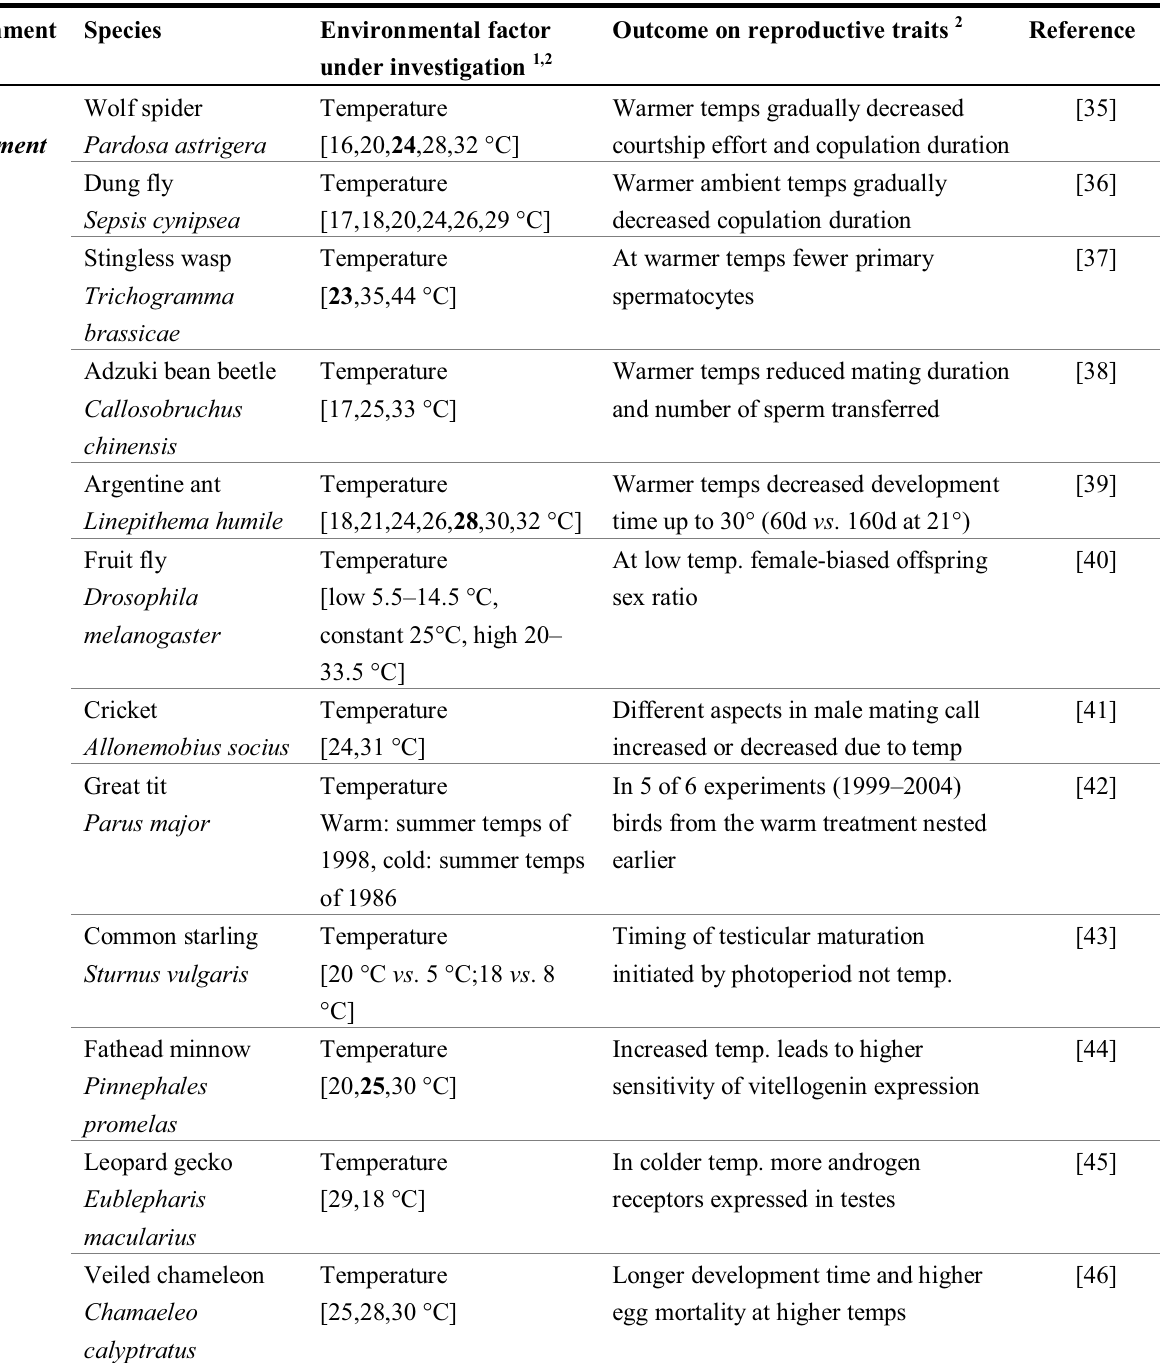
Table 1. Examples of studies assessing consequences of climate change, in particular effects of temperature, on reproductive traits. The studies are divided between lab-based experiments using different controlled temperature treatments, and experiments investigating reproductive traits in the field by observing or simulating changes to natural and anthropogenic climate